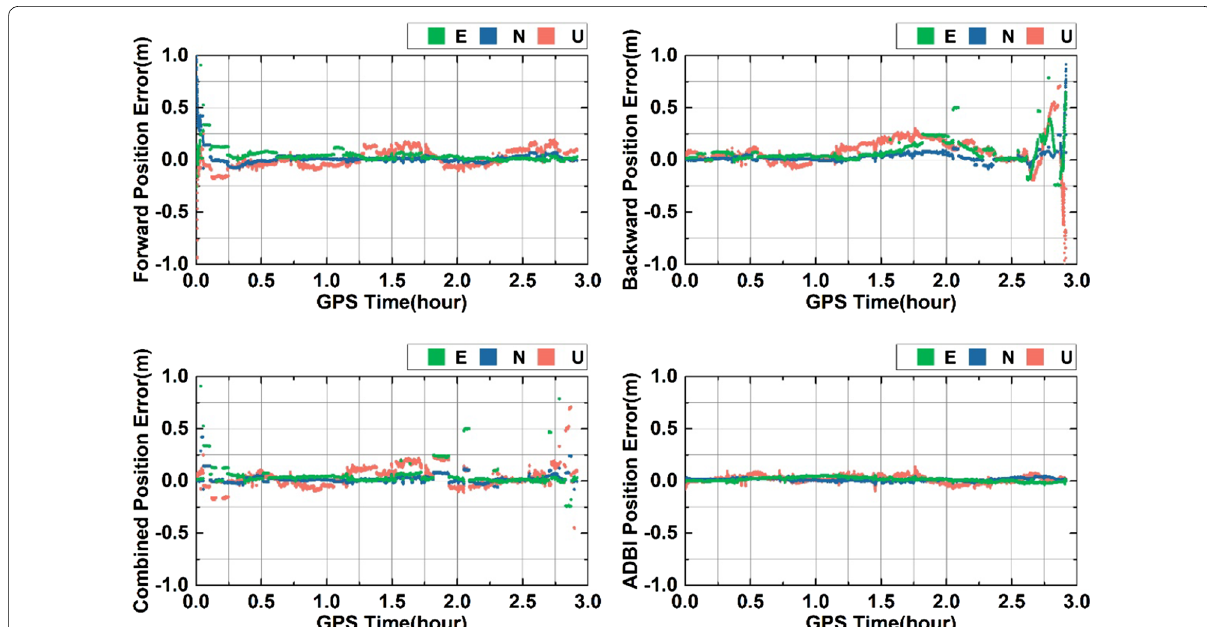
Fig. 10 Positioning biases with IF model in the forward filter ( top left ), backward filter ( top right ), post-processing results with FBC method ( bottom left ) and result with ADBI strategy ( bottom right ) using airborne data